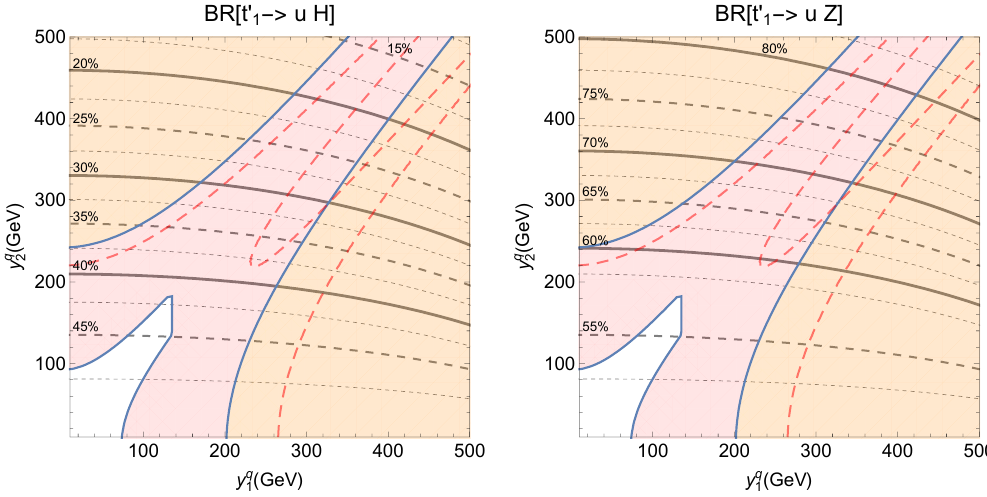
Figure 6 . Branching ratios of t 0 mixing with the up/charm quark. The contours are show for 1 values of the BR spaced by steps of 2 : 5%. For the light quarks, the orange region is excluded for the charm, while the orange plus pink areas are excluded for the up. The dashed line indicate the region excluded by EWPTs for mixing to the